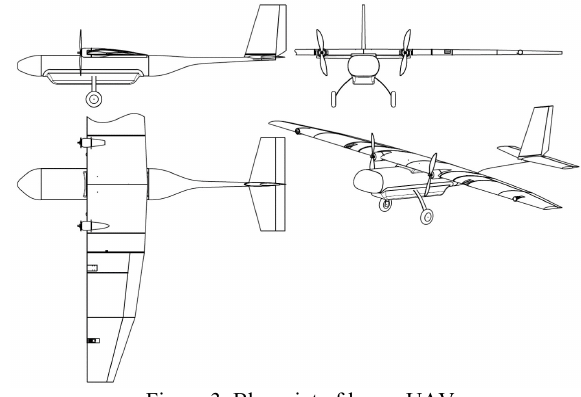
Figure 3. Blueprint of larger